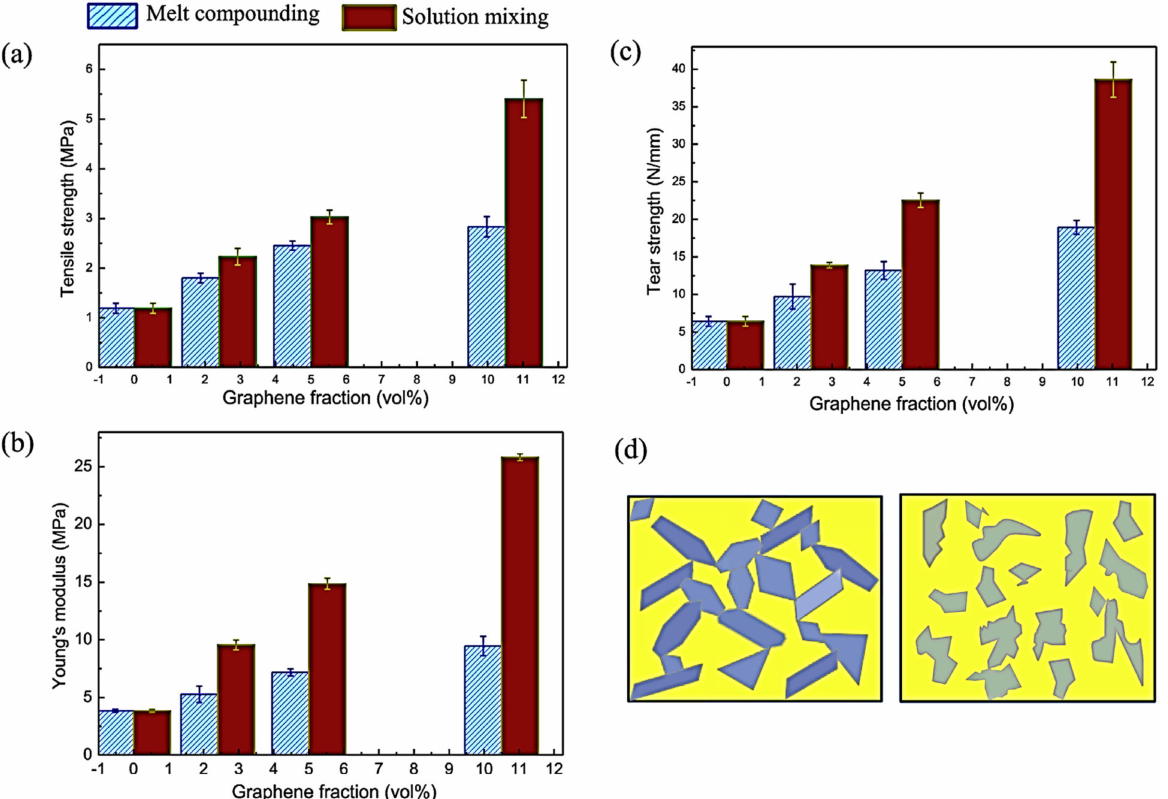
Figure 4. Solution mixing vs. melt compounding: ( a ) tensile strength; ( b ) Young’ modulus; ( c ) tear strength; and ( d ) schematic of nanocomposites by solution compounding (left) and melt mixing (right) [42]. Reproduced with permission from